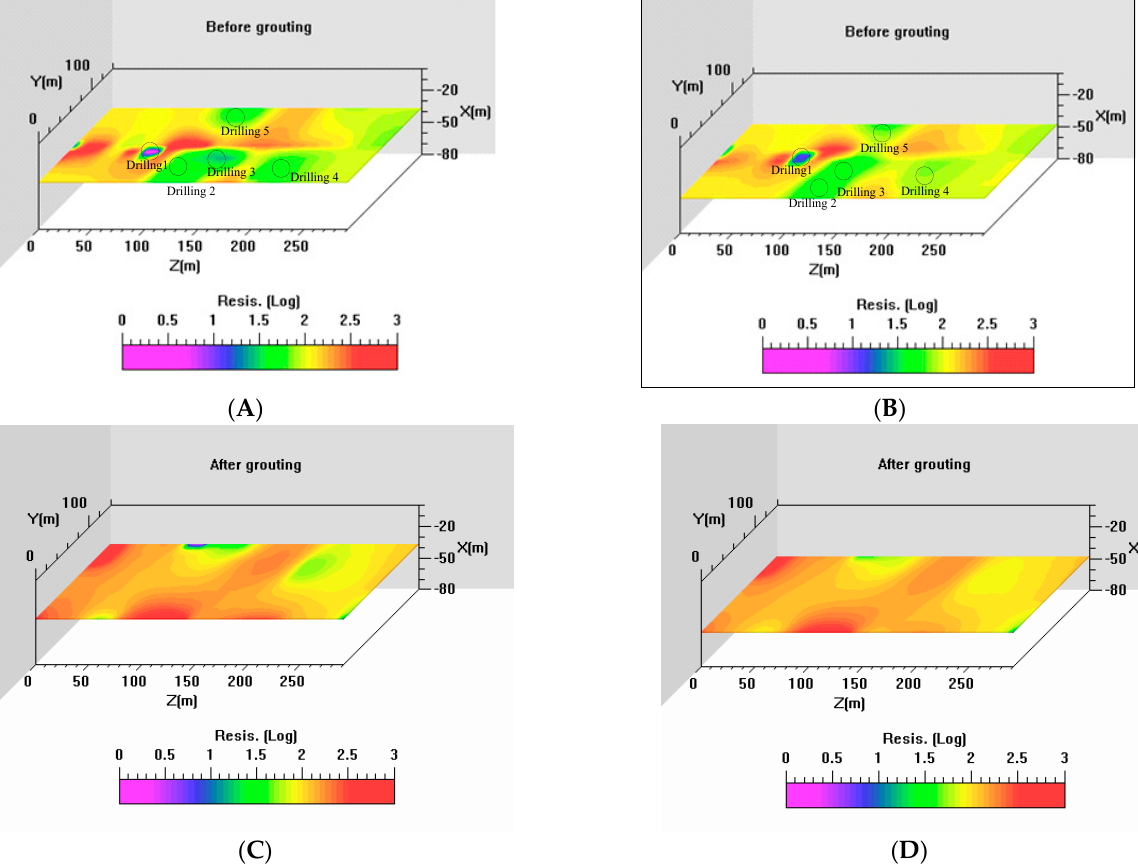
Figure 7. Resistivity profile of the working face floor aquifer before and after grouting: ( A ) Resistivity profile of the NO.5 LS aquifer before grouting; ( B ) Resistivity profile of the OLS aquifer before grouting; ( C ) Resistivity profile of the NO.5 LS aquifer after grouting; ( D ) Resistivity profile of the OLS aquifer. Table 1. Statistical data of drilling water inflow. Name of